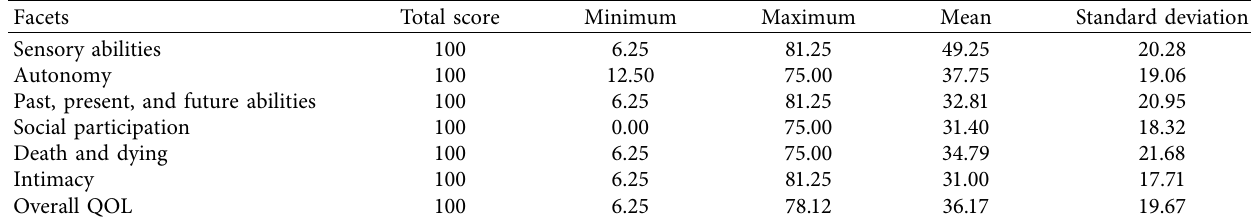
Table 4: Descriptive statistics of transformed score of QOL of geriatric population.